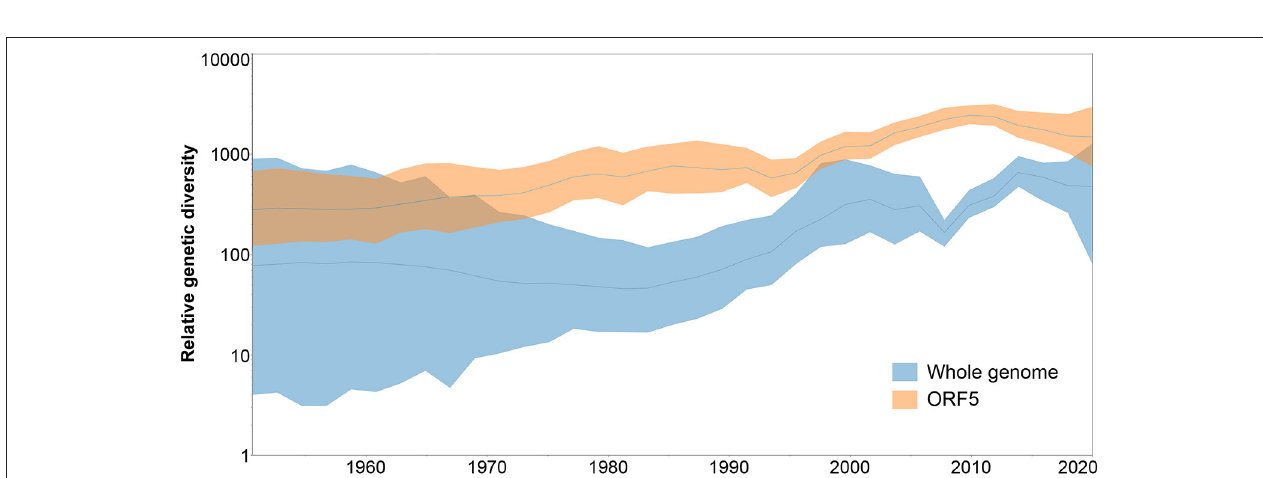
FIGURE 4 | Spatiotemporal patterns in the relative genetic diversity represented through the Bayesian SkyGrid plot, where dark lines represent the mean values, while shaded light regions correspond to the 95% highest posterior density (HPD).